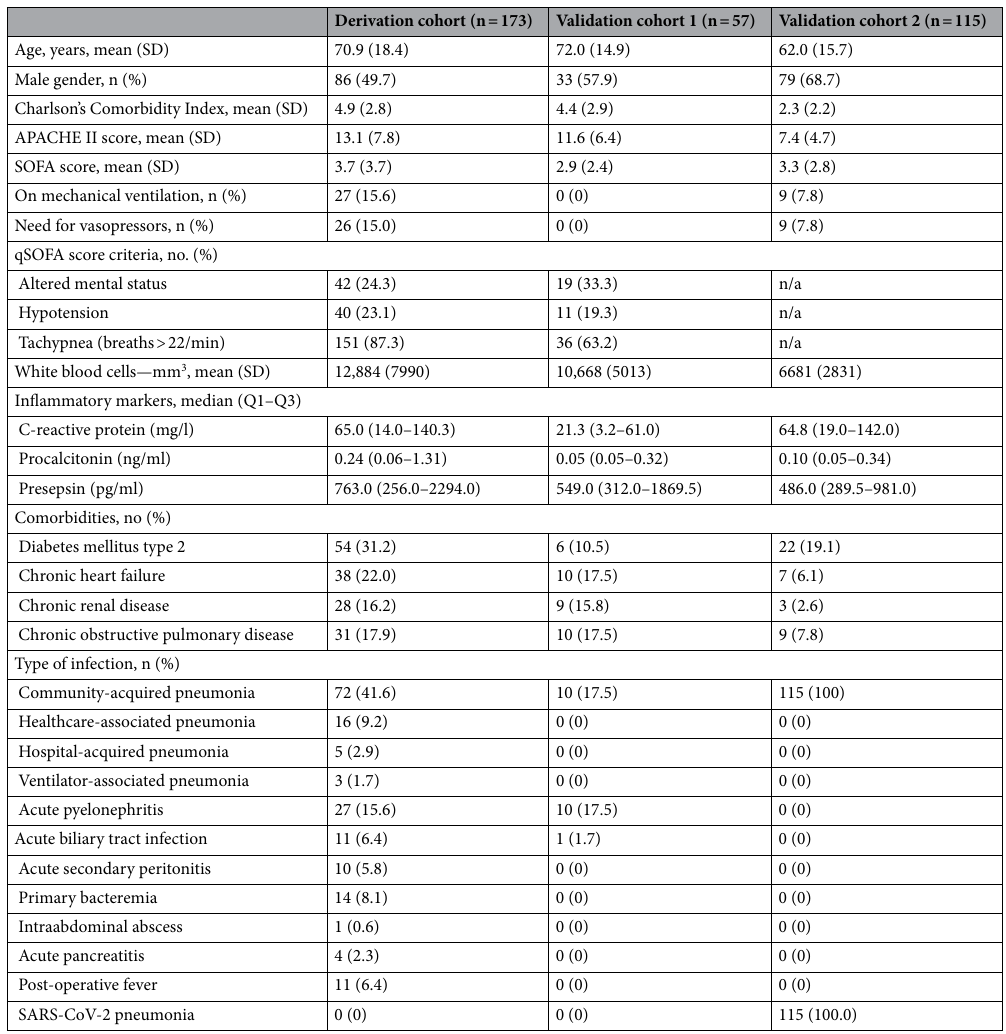
Table 1. Baseline characteristics of patients in the derivation and validation cohorts. APACHE acute physiological assessment and chronic health evaluation, n/ a non-available, SD standard deviation, SOFA sequential organ failure assessment, Q